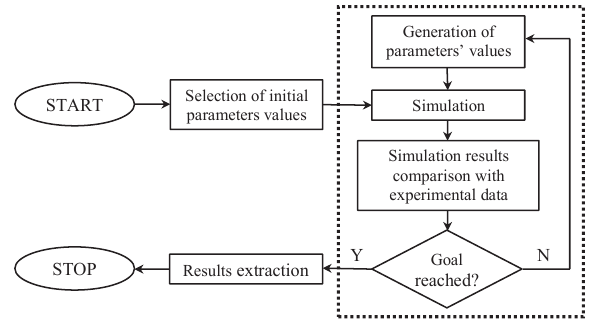
Figure 1. Inverse calibration operation diagram. Figure 1: Inverse calibration operation